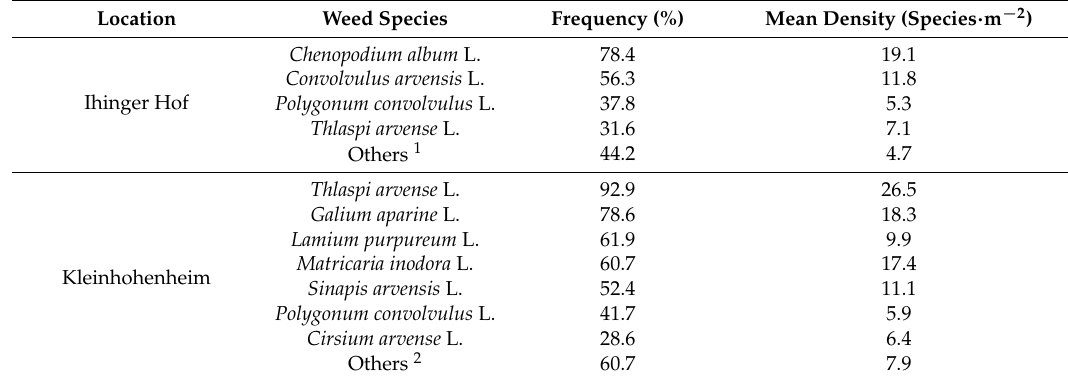
Table A2. Weed composition at the two research locations Ihinger Hof and Kleinhohenheim in